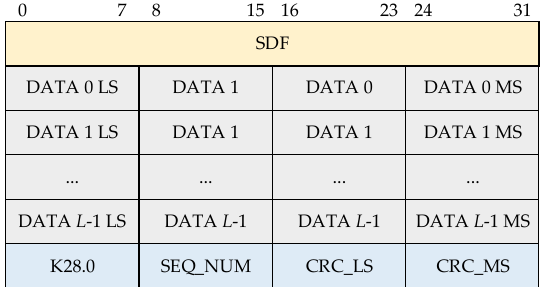
Figure 1. Data frame format for a multi-lane link.